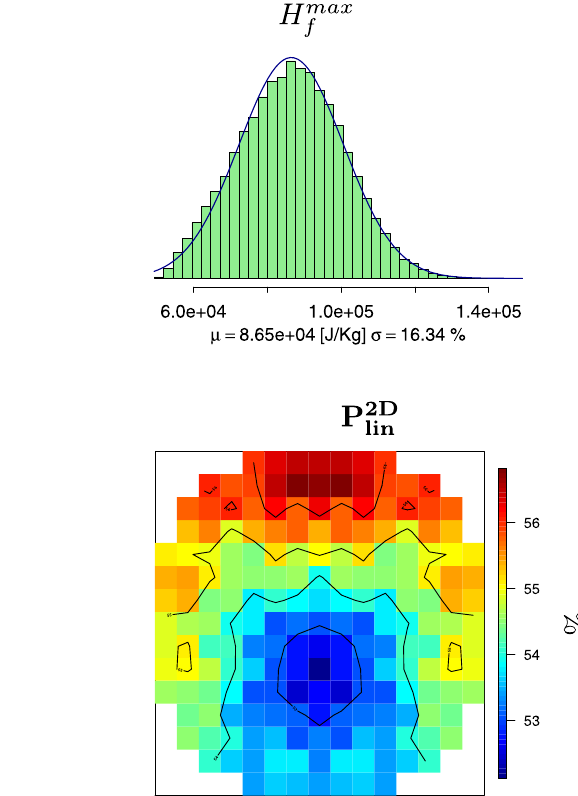
relative standard deviation distribution for IBE UQ lin